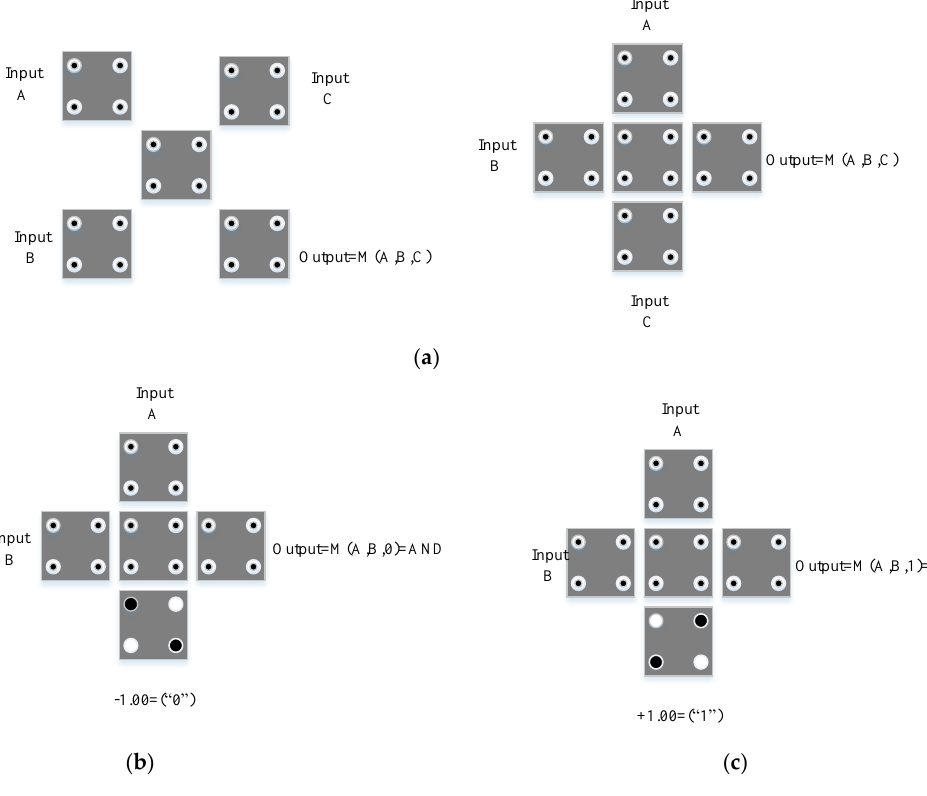
Figure 5. ( a ) QCA with implementation of the majority gate, ( b ) QCA with implementation of the AND Gate with two inputs and ( c ) QCA with implementation of the OR Gate with two